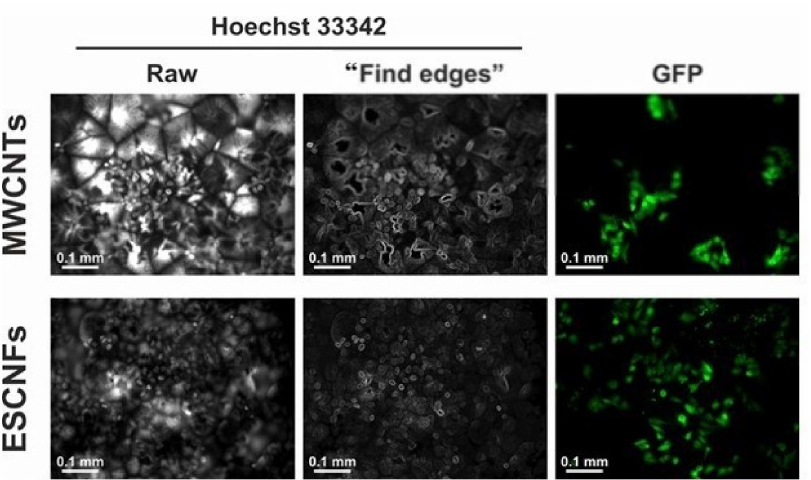
Figure 9. U-2 OS-Green cells distribution on PCL/MWCNTs and on PCL/ESCNFs on the 2nd day of culture. The specimens were live-stained with Hoechst 33342 to visualize cell nuclei. As shown in the “Raw” column, Hoechst stained not only cell nuclei but also the material (white signal, left panels). Thus, a “find edges” algorithm was used to visualize the shape of cell nuclei (the central panels). Right panels present GFP signal from the